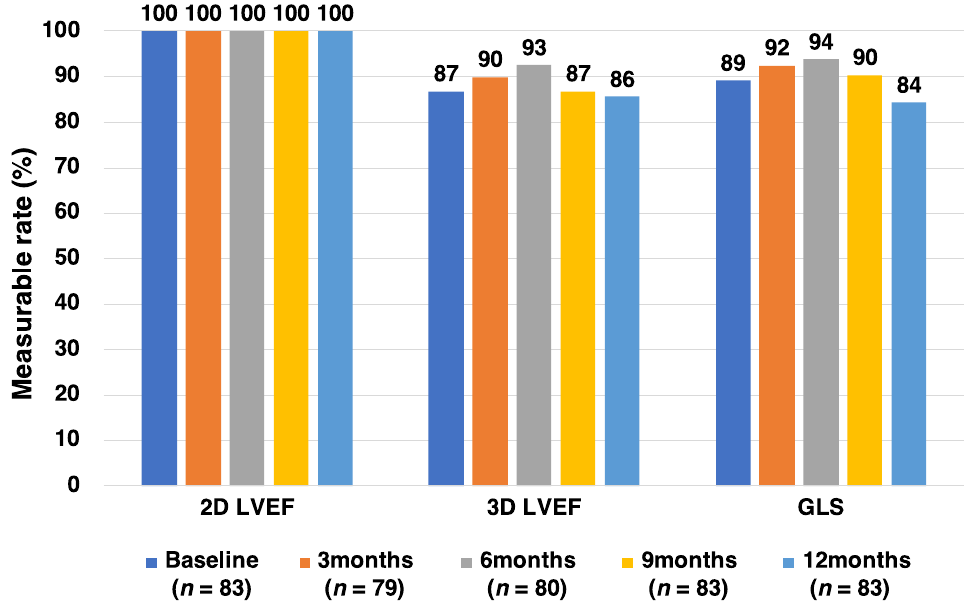
Figure 3. Measurable rates of 2D LVEF, 3D LVEF, and GLS.2D: Two-dimensional, 3D: Three-dimensional, GLS: Global longitudinal strain, LVEF: Left ventricular ejection fraction.